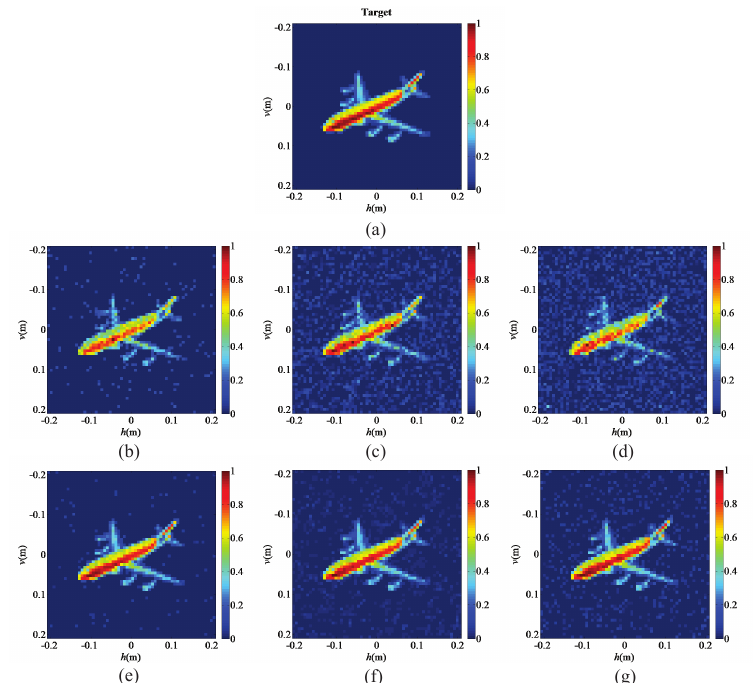
Figure 6. Reconstruction results for extended target: ( a ) original extended target; ( b ) OMP algorithm before compensation; ( c ) TVAL3 algorithm before compensation; ( d ) SBL algorithm before compensation; ( e ) OMP algorithm after compensation; ( f ) TVAL3 algorithm after compensation; ( g ) SBL algorithm after